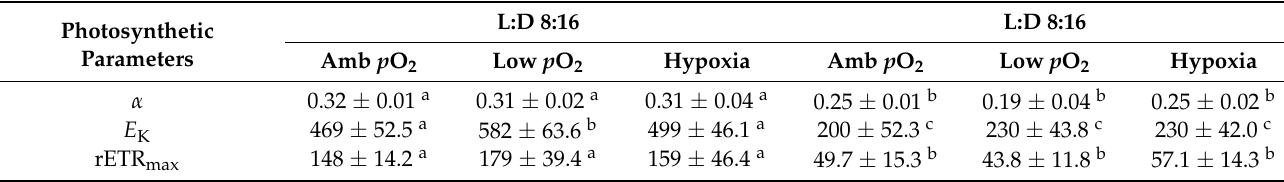
Figure 3. Maximal photochemical quantum yield of PSII (( A ), F V /F M ), photosynthetic oxygen evolution rate (( B ), fmol O 2 cell − 1 min − 1 ) and dark respiration rate (( C ), fmol O 2 cell − 1 min − 1 ) of T. pseudonana grown under 8:16 and 16:8 L:D cycles, under ambient p O 2 , low p O 2 , and hypoxia. The vertical bar shows the standard deviation ( n = 3), and different letters on top of the bar indicate the significant differences ( p < 0.05, one-way ANOVA). Table 1. The rapid light curve (RLC)-derived light utilization efficiency ( α ), saturation irradiance (E K , µ mol photons m − 2 s − 1 ), and maximal relative electron transport rate (rETRmax) of T. pseudonana grown under 8:16 and 16:8 Light:Dark cycles, under ambient p O 2 (Amb p O 2 ), low p O 2 , and hypoxia.